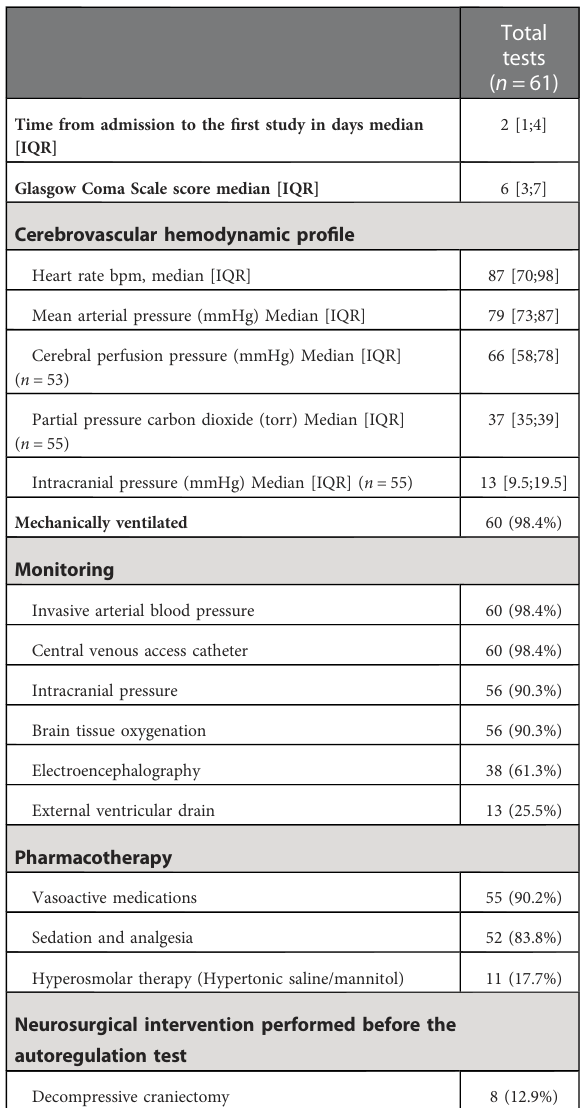
TABLE 2 Clinical setting of transcranial Doppler ultrasonography based cerebral autoregulation testing was performed.